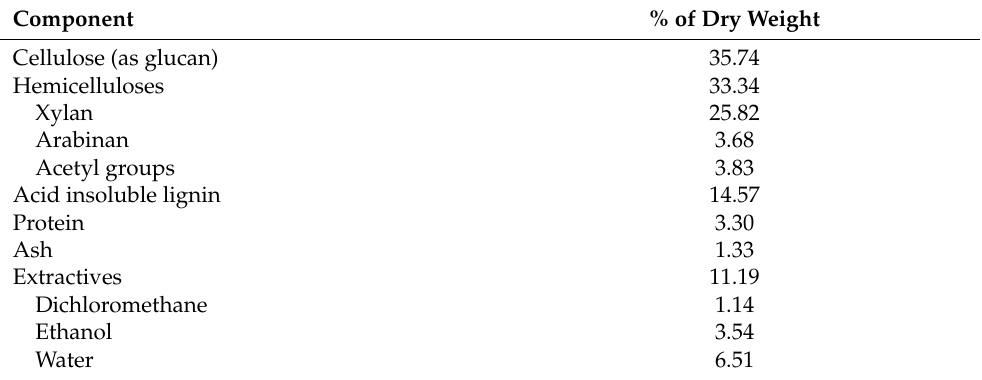
Table 1. Chemical composition of corn cobs.